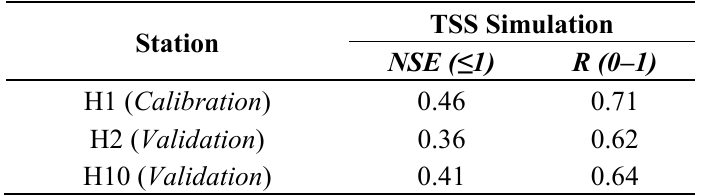
Table 3. Performance evaluation statistics of TSS simulation.